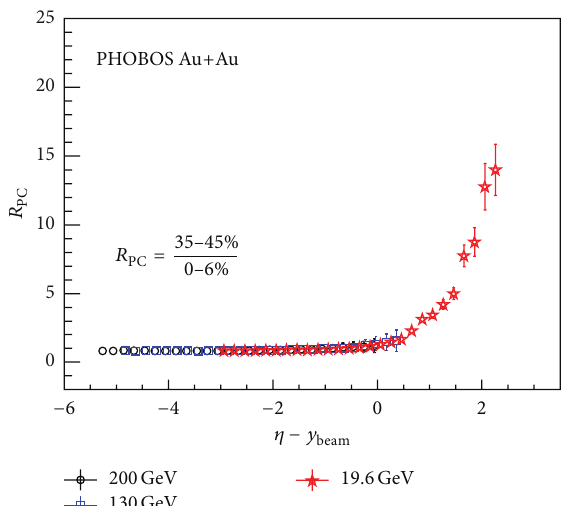
for Cu+Cu collisions beam